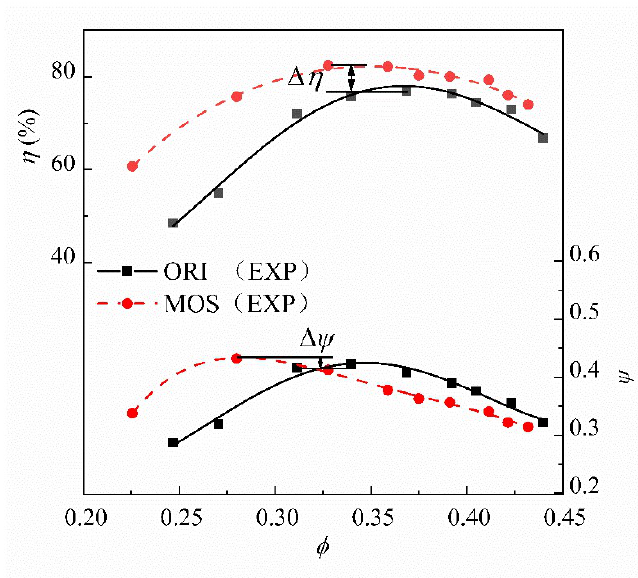
Figure 20. Experimental performance curves of optimized and prototype